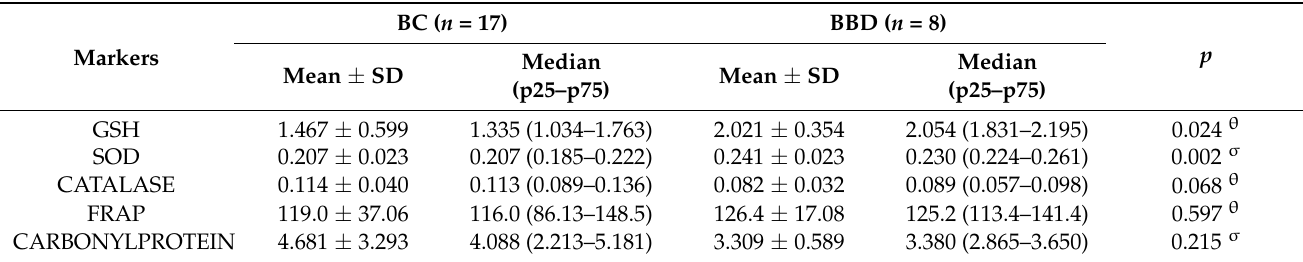
Table 3. Profile of redox status markers among women with breast cancer and benign breast disease at a university hospital in Uberlandia, Minas Gerais, Brazil ( n = 25).